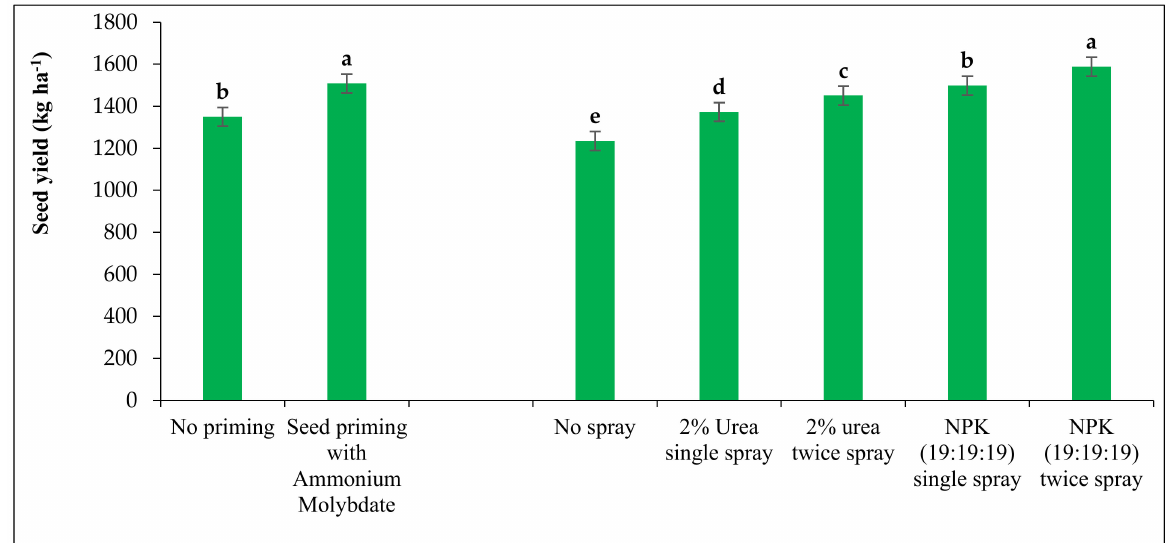
Figure 8. Seed yield of grass pea as influenced by seed priming and foliar nutrition (pooled means of 2 years) (Different letters in all bars denote significant differences between means.)